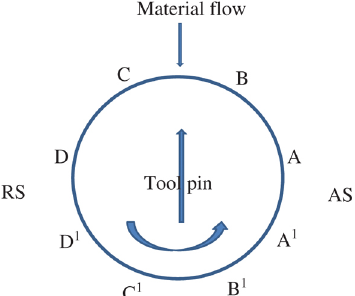
Figure 9: Plan view of the tool pin; angular arrow is the rotational direction and arrow is the welding